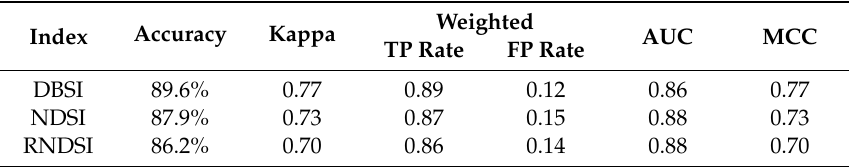
Table 4. Performance evaluation metrics of various indices (DBSI, NDSI, and RNDSI) in detecting the soiled and clean pixel as verified from PlanetScope